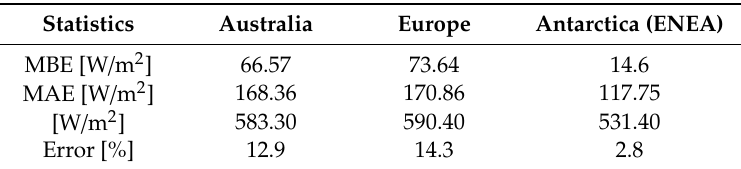
Table 2. Model comparators with di ff erent regional Boland–Ridley coe ffi